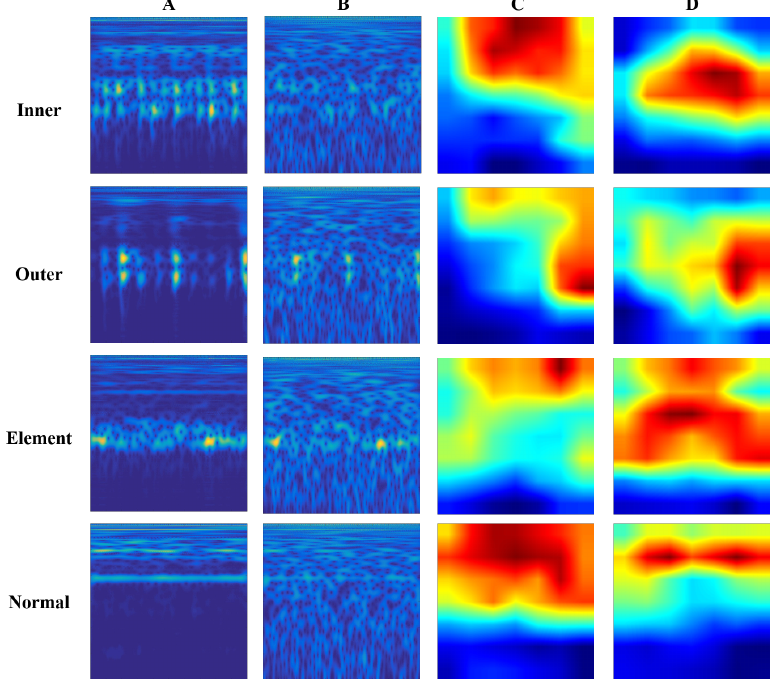
Figure 8. The attention weight visualization of proposed method. ( A ) Original TFRs; ( B ) TFRs with additional noise; ( C ) weight distribution of EfficientNet; ( D ) weight distribution of attention EfficientNet.